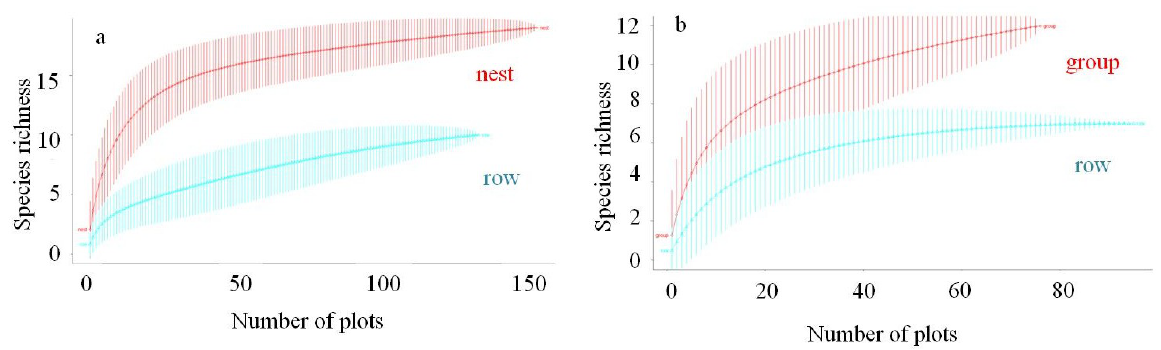
Figure 3. Rarefaction curves for nest vs . row planting ( a ) and group vs . row planting ( b ), the number of species is standardized by number of vegetation plots ( x axis) and accumulated with total number of species ( y axis). Confidence intervals are shown as vertical lines.